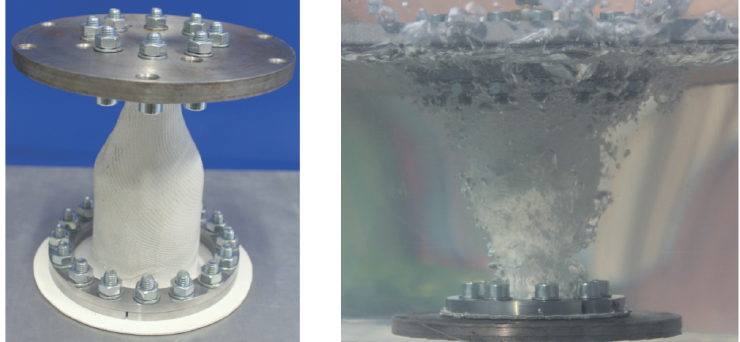
Figure 22. ( left ) combustion chamber and nozzle closed with metal plates and ( right ) leaks at the nozzle-side flange connection that occurred during the pressure test.